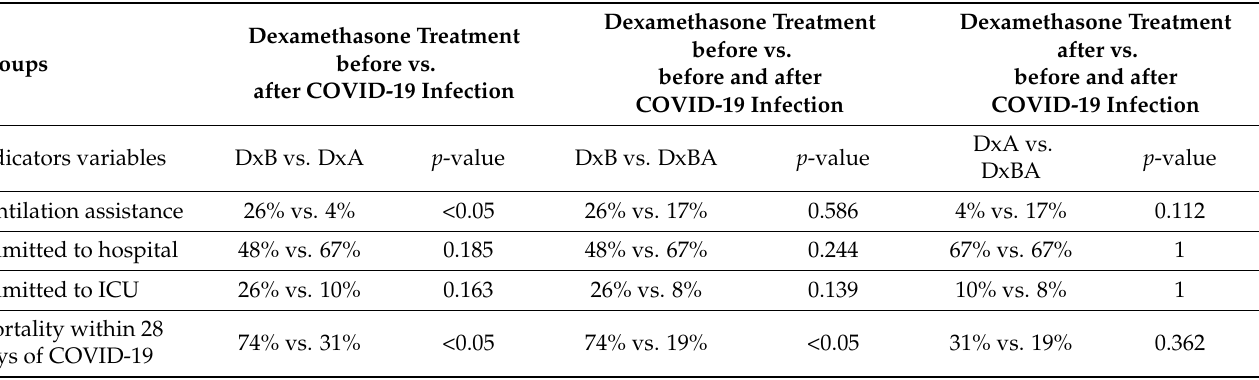
Table 4. Comparison between different dexamethasone treatment